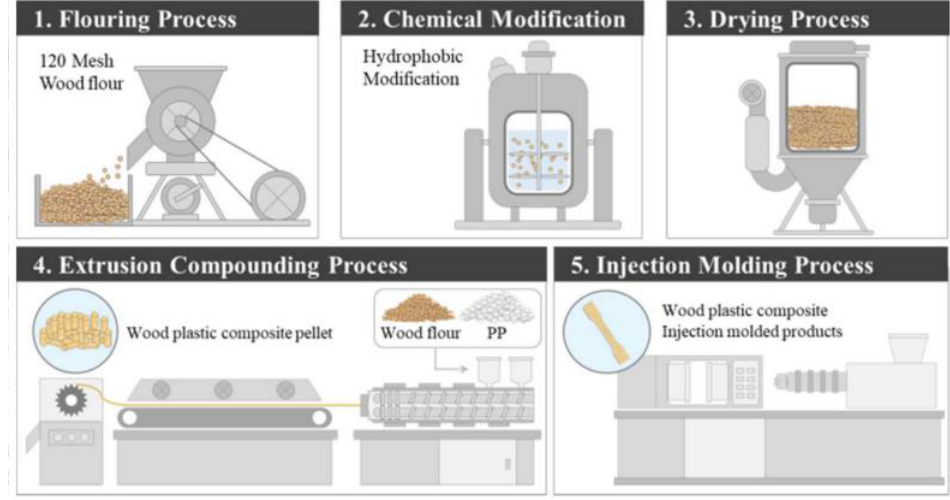
Figure 1. A schematic of the experimental